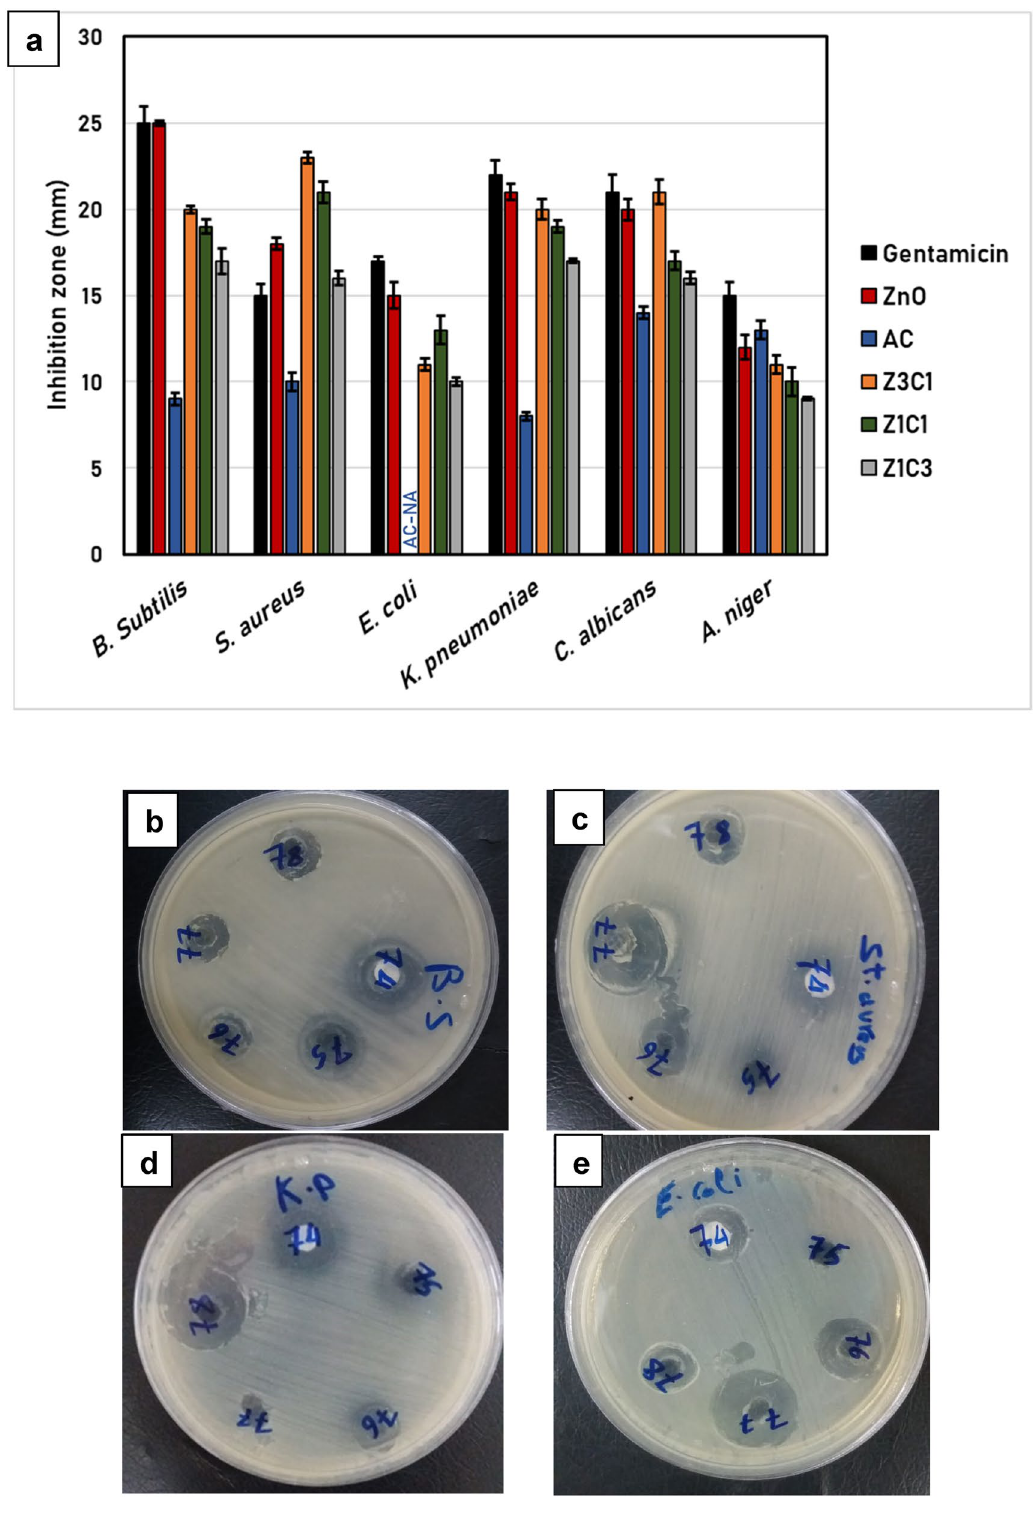
Figure 1. ( a ) Antimicrobial impact of the synthesized ZnO/AC nanocomposites against Gram-positive, Gram-negative bacteria, and unicellular and multicellular fungi. The values are the average of 3 replicates expressing the diameter of the clear zones (mm), while the error bars represent standard deviations. (NA): no activity; Samples for the antimicrobial impact of the synthesized nanocomposites against ( b ) Bacillus subtilis ; ( c ) Staphylococcus aureus ; ( d ) Klebsiella pneumonia ; and ( e ) Escherichia coli . The codes of the wells are referring to the following: (74): neat ZnO NPs; (75): neat AC; (76): Z3C1; (77): Z1C1; (78):